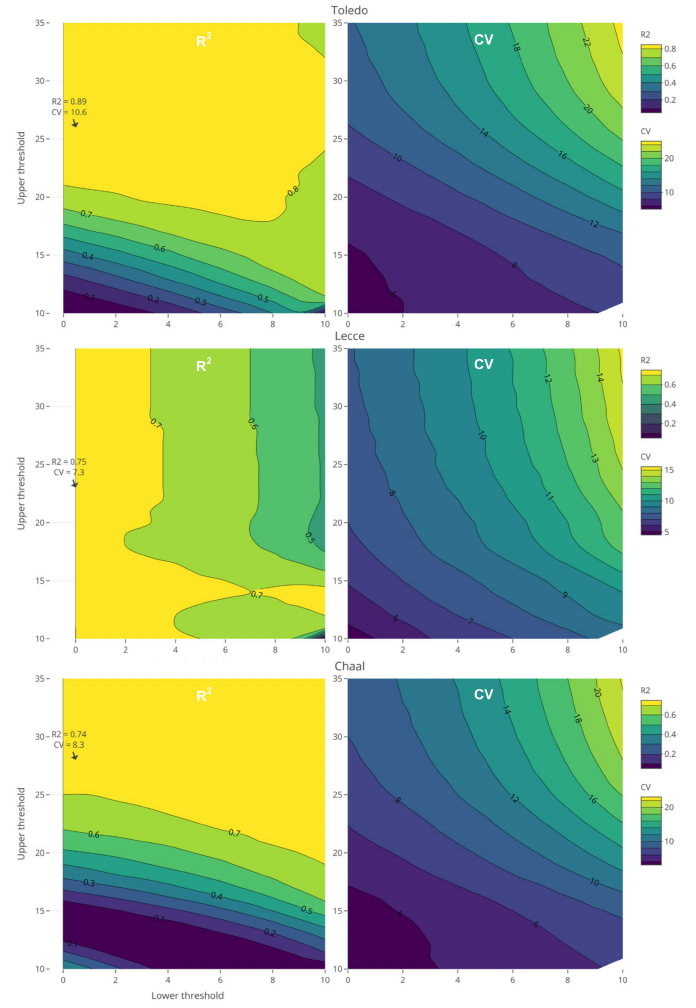
Figure 5. Selection of the most accurate heat accumulation thresholds based on the consensus between the maximum R 2 coe ffi cient (relationship heat accumulation—Onset of flowering) and lower coe ffi cient of variation